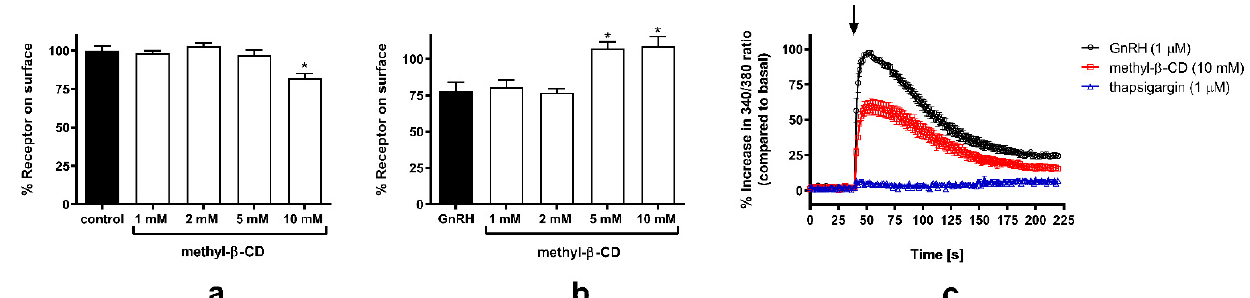
Figure 2. Effect of methyl- β -CD treatment on GnRH-R surface expression, agonist-induced internalization, and [Ca 2+ ] i in HEK-HAGnRH-R cell line. ( a ) ELISA was performed to determine the effect of increasing concentrations of methyl- β -CD treatment (from 1 to 10 mM; 1 h at 37 ◦ C) on the level of surface-expressed HAGnRH-R. Measurements were performed as described in Section 4, Material and Methods. Data (mean ± S.E.) are expressed as a percentage of the value obtained in untreated (control) cells from a single experiment performed in triplicate and are representative of a total of three independent experiments. * p < 0.05 versus control. ( b ) Effect of methyl- β -CD treatment on the agonist-induced HAGnRH-R internalization. HEK-HAGnRH-R cells were pretreated with assay medium containing increasing concentrations of methyl- β -CD (from 1 to 10 mM; 1 h at 37 ◦ C), and the methyl- β -CD concentration was maintained during ligand treatment (1 µ M D-Trp 6 -GnRH; 30 min at 37 ◦ C). The levels of surface-expressed receptors after agonist (GnRH) treatment in the absence or presence of methyl- β -CD. Data represent the mean ± S.E. of three independent experiments performed in triplicate. * p < 0.05 versus GnRH-treated cells. ( c ) Time-dependent changes in F 340 /F 380 ratio in HEK-HAGnRH-R cells upon exposure to 1 µ M D-Trp 6 -GnRH alone or 1 µ M D-Trp 6 -GnRH after pretreatment with 10 mM methyl- β -CD (methyl- β -CD) or 1 µ M thapsigargin in DPBS. Representative time-course data from one of at least three experiments performed in triplicate are shown. The time point of GnRH injection is marked by an arrow. Note the decreased response after pretreatment with methyl- β -CD, whereas thapsigargin almost completely prevents the increase in [Ca 2+ ] i .